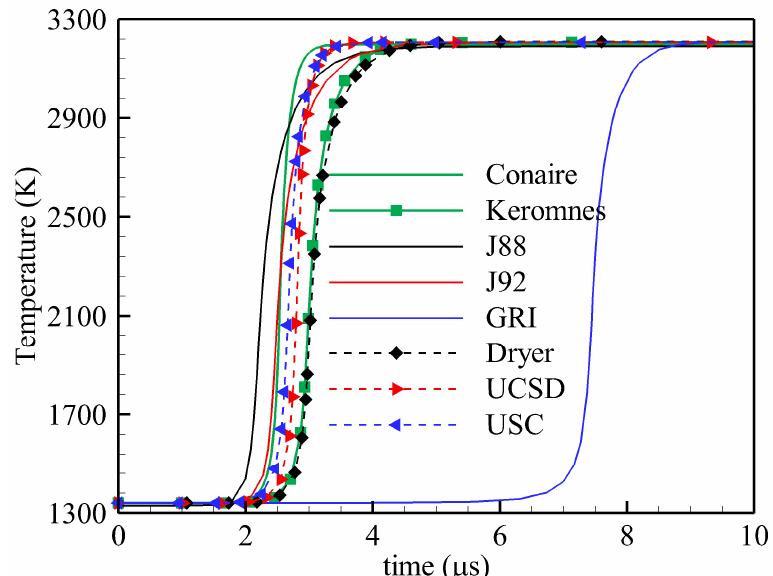
Figure 7. Temperature profile for various reaction mechanisms calculated from the CV explosion model.